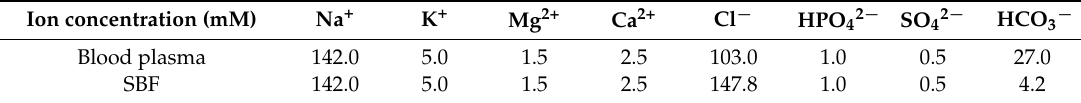
Table 1. Ionic concentrations (mM) in simulated body fluid (SBF) and in human blood plasma [49]. Ion concentration (mM) Na + K + Mg 2+ Ca 2+ Cl − HPO 42 − SO 42 − HCO 3 − Blood plasma